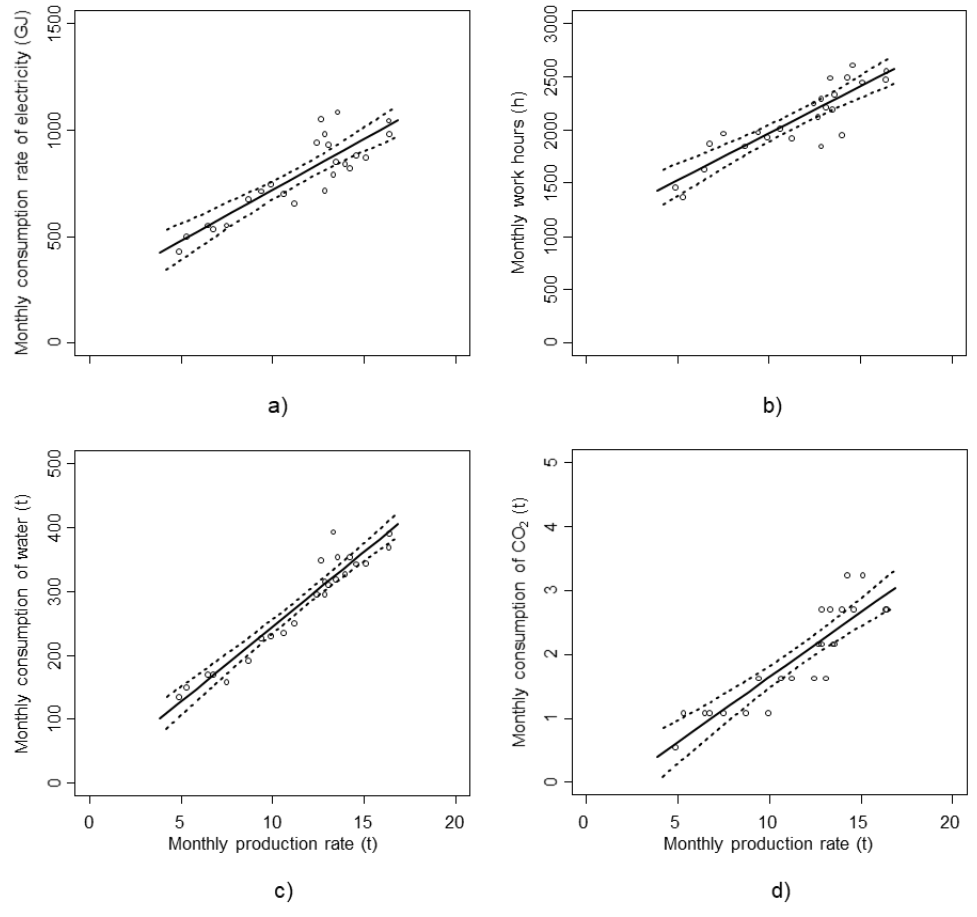
Figure 2. Monthly consumption rates of: ( a ) Electricity; ( b ) labor (work hours); ( c ) water; ( d ) CO 2 as affected by the monthly production rate of lettuce. Regression lines (solid line) are shown with a 95% interval level (dotted lines). Numerical data are presented in Table